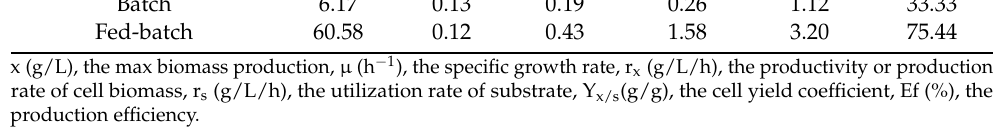
Table 6. Growth kinetic parameters of G03H8 cultivations in batch and fed-batch fermentation. Fermentation Method